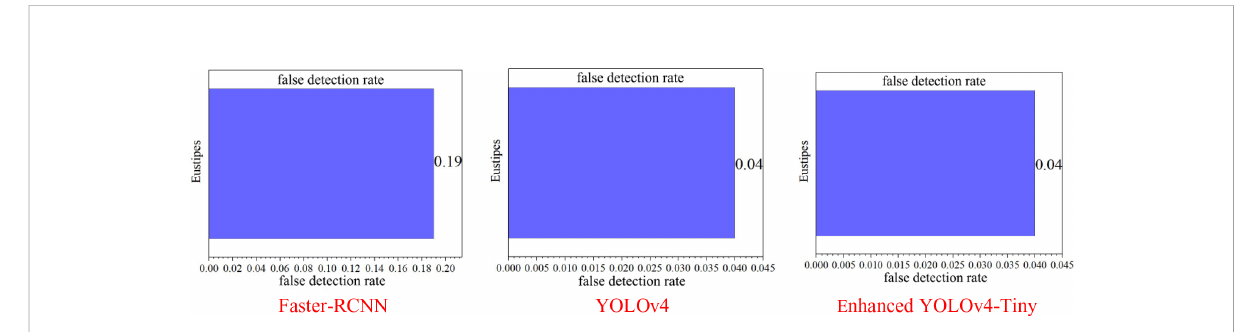
FIGURE 11 False detection rate of sugarcane stem segment recognition under different models.